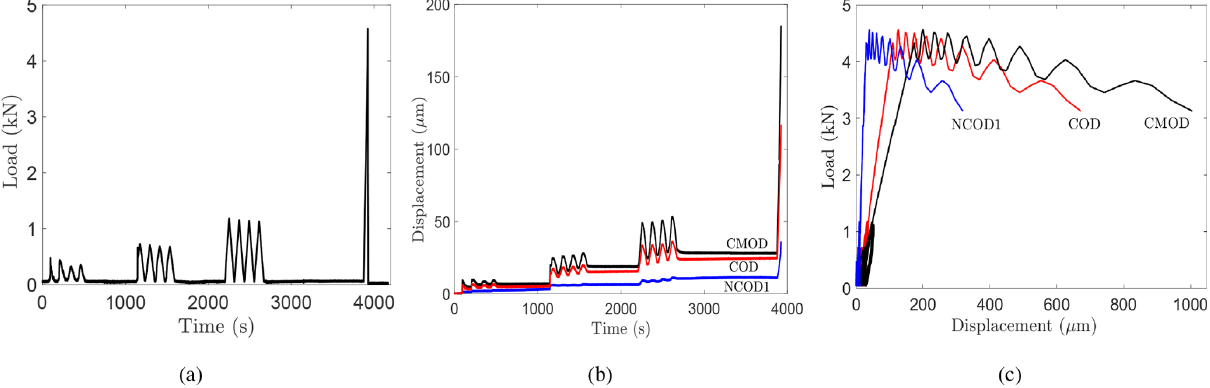
Figure 8. Experimental results for RP17. (a) Load at the crack mouth; see Fig. 1. (b) Displacement–time records. (c) Load–displacement